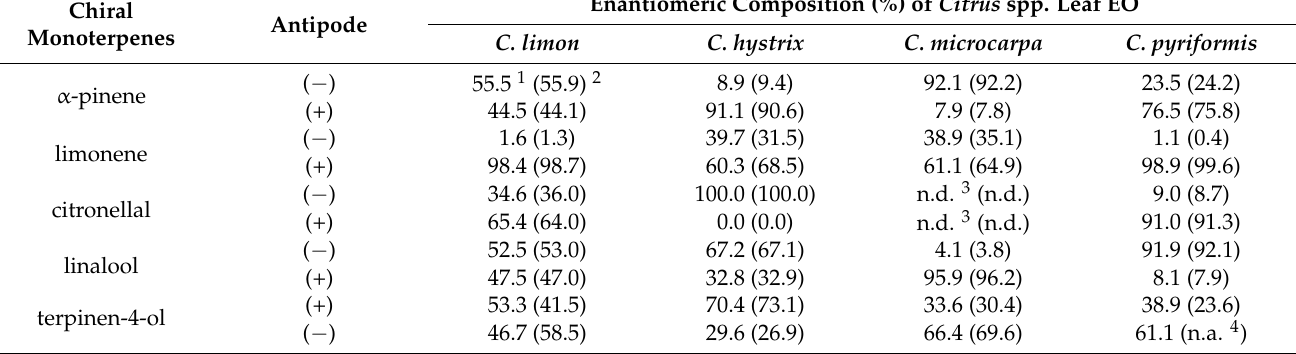
Table 1. The enantiomeric composition (%) of selected chiral monoterpenes analyzed in Citrus spp. leaf EOs using the proposed e GC–FID and e GC × GC–FID